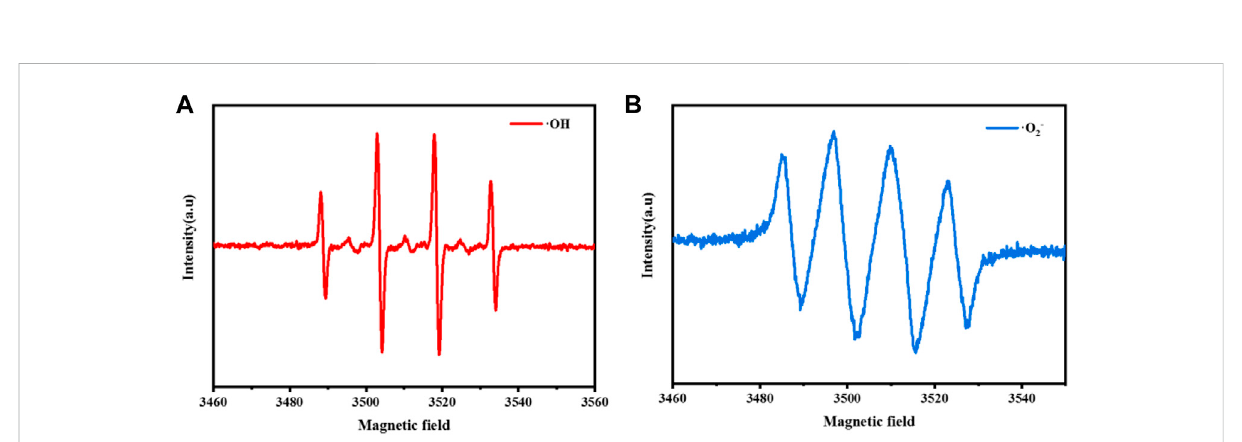
FIGURE 13 EPR characterization of CuCo/SCN involved Fenton-like system: (A) DMPO- · OH, (B) DMPO- · O 2 − .